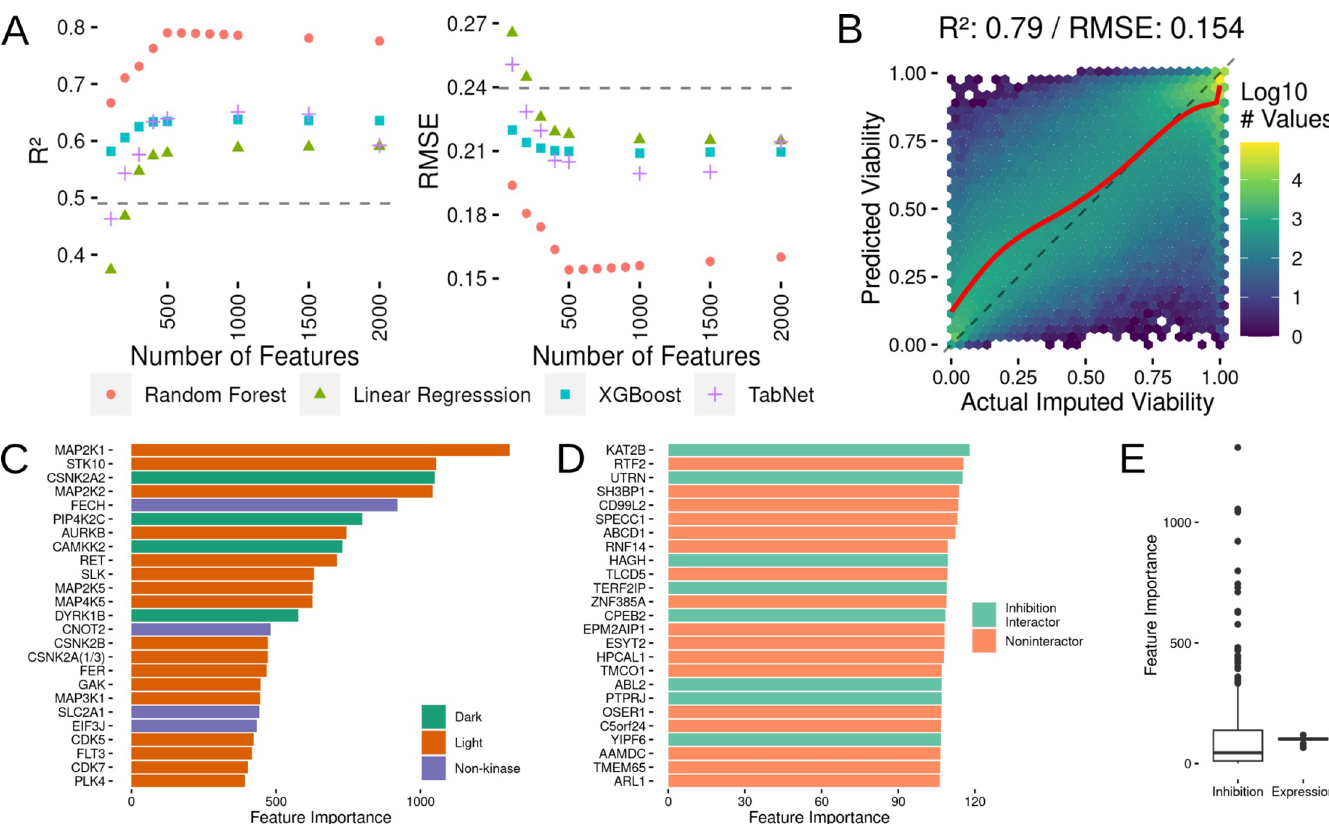
Fig 3. Development of a Regression Model to Predict Cell Viability and Assessment of Which Features Contribute to Model Predictions. (A) Comparison of R 2 and RMSE values from linear regression, random forest, XGBoost and TabNet models. The gray dotted line shows the performance level of a dose-only model performance. (B) Actual imputed viability versus cross validated model predictions for the random forest model. The dashed line indicates where a perfect set of predictions would appear, while the red line shows a loess fit through the actual results. (C) Variable importance plot for the top 25 features in the final regression model. Each feature is prefixed with act or exp representing either kinase inhibition or gene expression respectively. (D) The top 25 most important expression features in the final model. (E) The overall distributions of feature importance values for the inhibition and expression features.